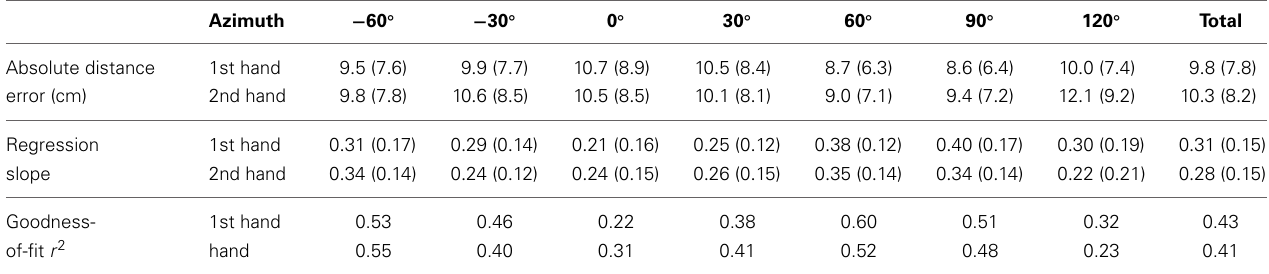
Table 2 | Mean of absolute distance error (standard deviations in parenthesis), slope of the regression line and goodness-of-fit criteria r 2 for each azimuth and hand